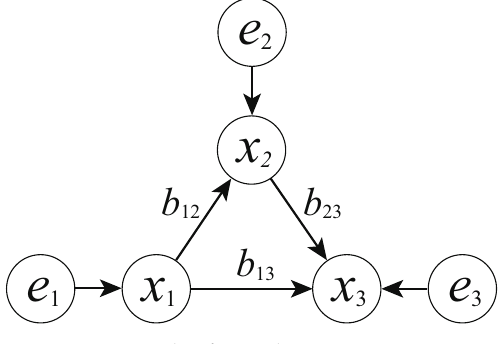
Figure 1. Example of causal